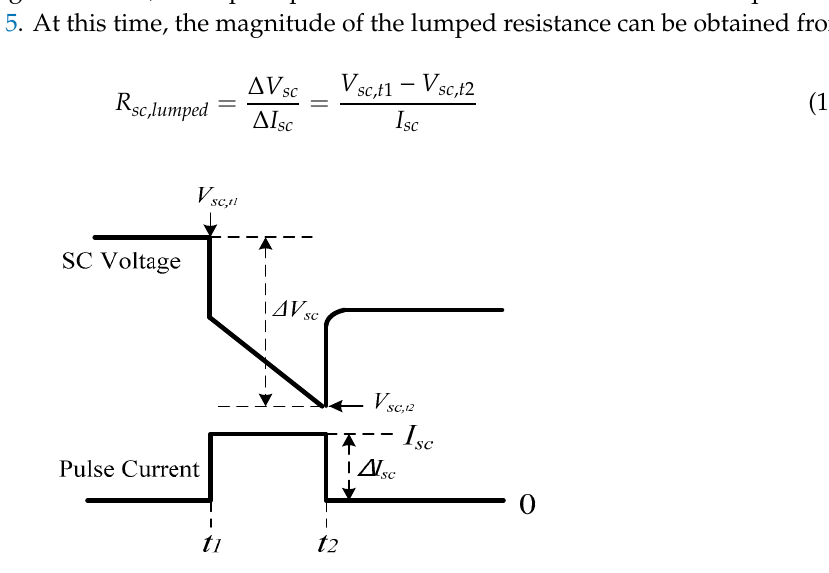
Figure 4. Voltage response of supercapacitor during the pulse current.